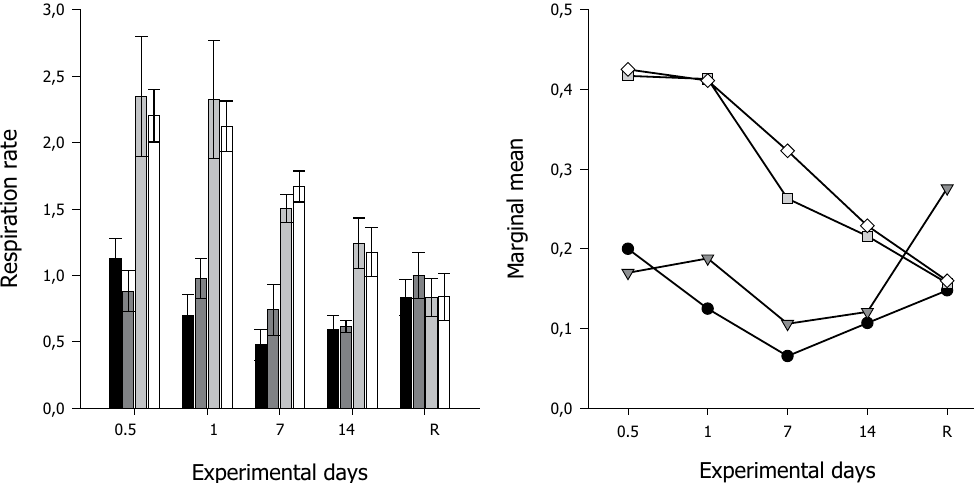
Figure 1. Left panel –Mean respiration rate ( μ mol O 2 g (tissue DW) − 1 h − 1 ) ± S.E. (n = 5) of cultivated G. barretti explants exposed to four different temperature levels (7 °C–Black bar, 9 °C–Dark grey bar, 11 °C–Light grey bar & 12 °C–White bar) over a 14 d experimental period. R on the x-axis is respiration at 65 d post exposure (the recovery period), with explants being maintained at ambient temperatures (7 °C) after the 14 d experimental period, irrespective of prior temperature exposure. Right panel –Interaction plot of estimated marginal means of respiration rates calculated for each temperature (7 °C–Black circles, 9 °C–Dark grey triangles, 11 °C–Light grey squares & 12 °C–White diamonds) at each exposure day and recovery time period (R).